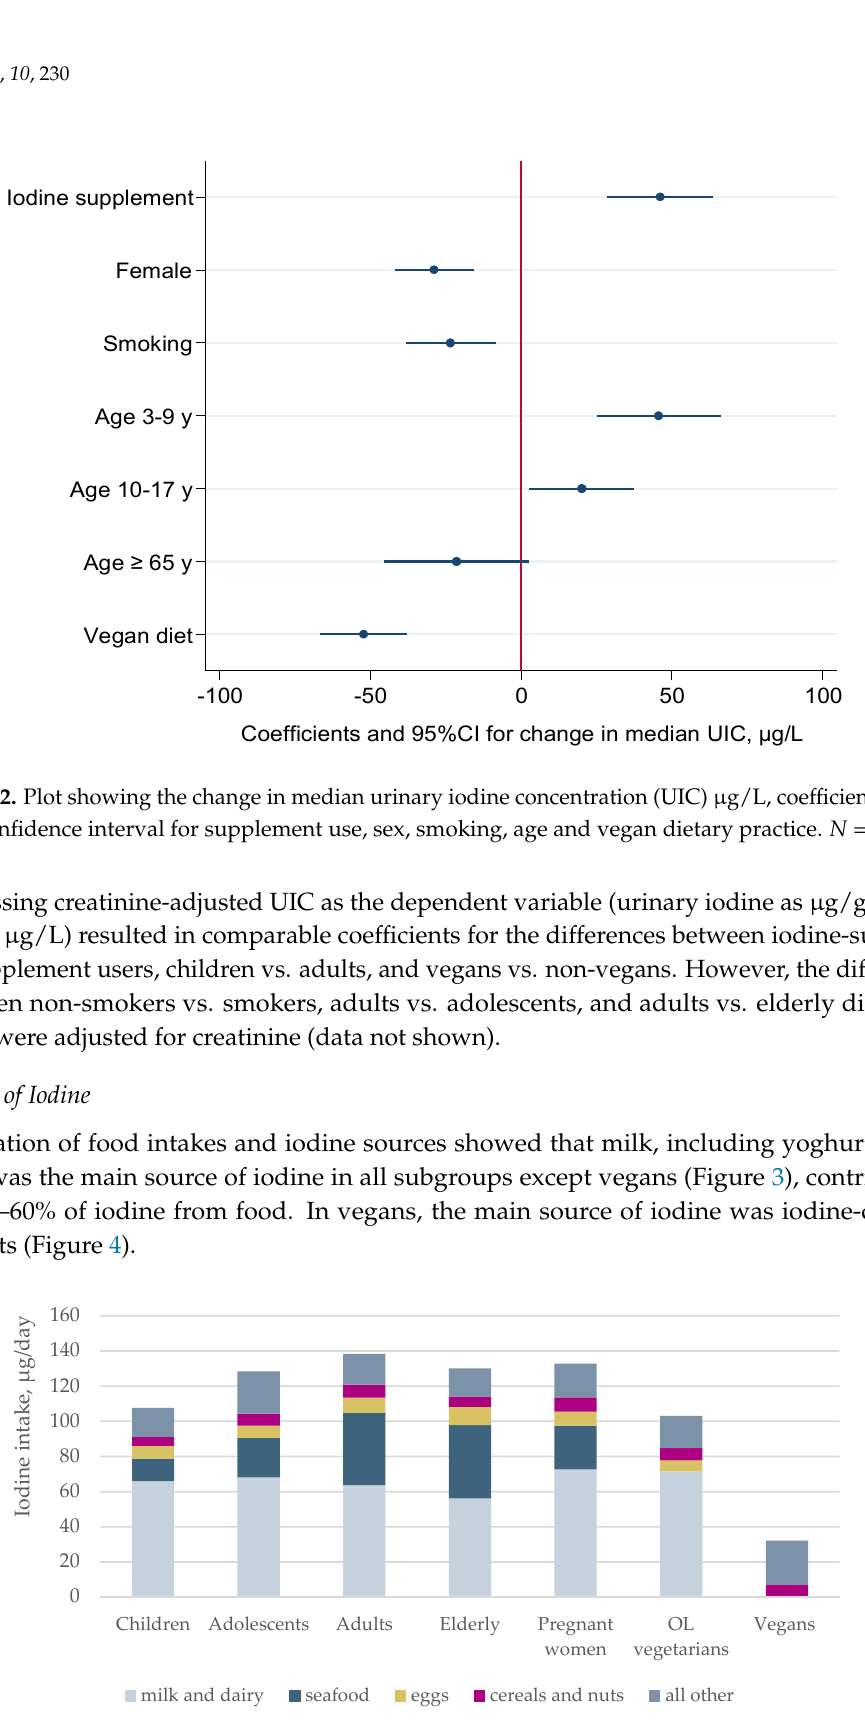
Figure 3. The mean contribution to iodine intake ( μ g/day) from different food groups in children, adolescents, adults, the elderly, pregnant women, ovo ‐ lacto (OL) vegetarians and vegans.